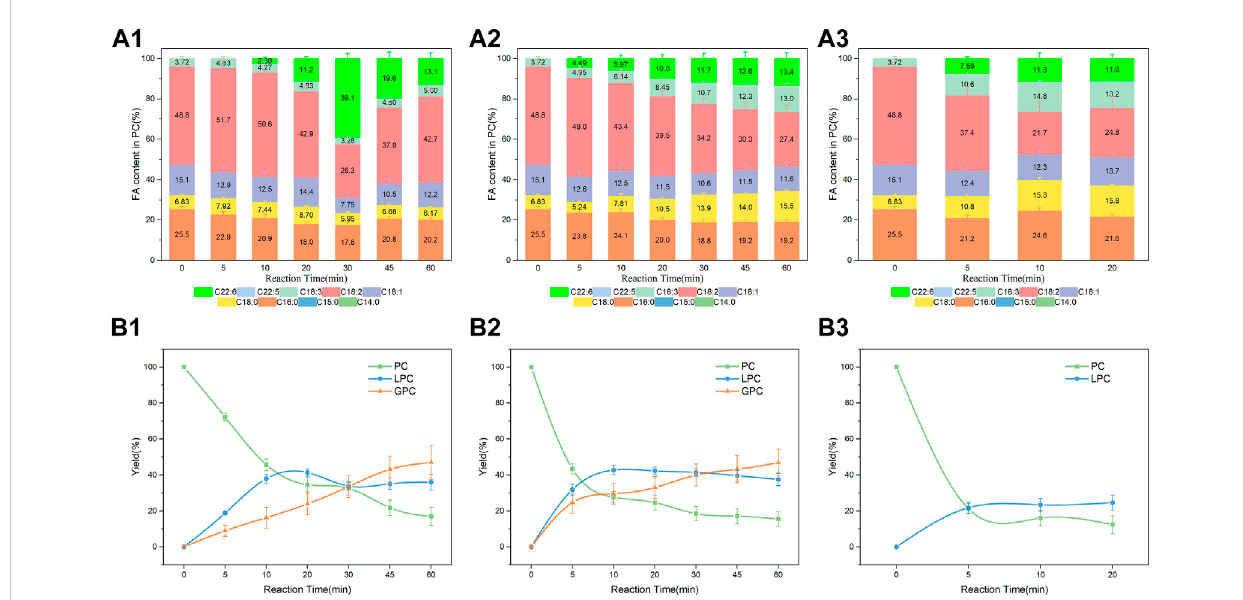
FIGURE 5 Effect ofwatercontenton thePLA1-mediatedtransesteri fi cation; Pro fi lesofFA intheproductPC containing (A1) 0.7 wt %water inthemixture; (A2) 1.2 wt%waterinthemixture; (A3) 1.7 wt%waterinthemixture;YieldoftheproductPCandLPCcontaining (B1) 0.7 wt%waterinthemixture; (B2) 1.2 wt %water in the mixture; (B3) 1.7 wt % water in the mixture; Reaction conditions: 20 mgPC, 1.0 g algae oil, 10 µL PLA1, 45 ° C, 500 rpm. Notes: water herein refers to phosphate buffer solution (PBS, 0.1 M, pH